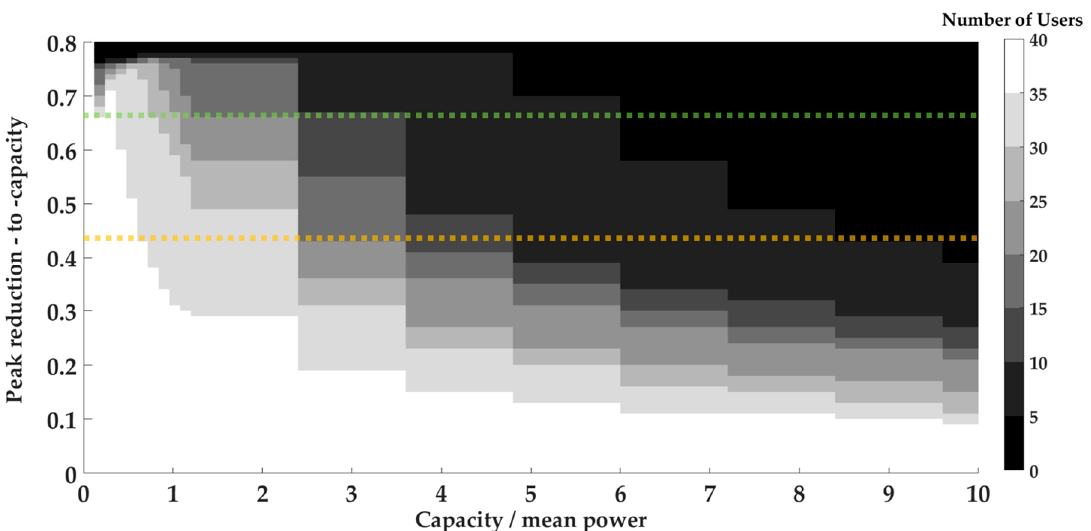
Figure 8. Peak shaving—results of economic feasibility study. At each point [x, y], the color represents the total number of users whose peak reduction-to-capacity exceeds the y value. The yellow and green dashed lines represent the profitability thresholds 0.43 and 0.67, respectively (see Equation (16)).